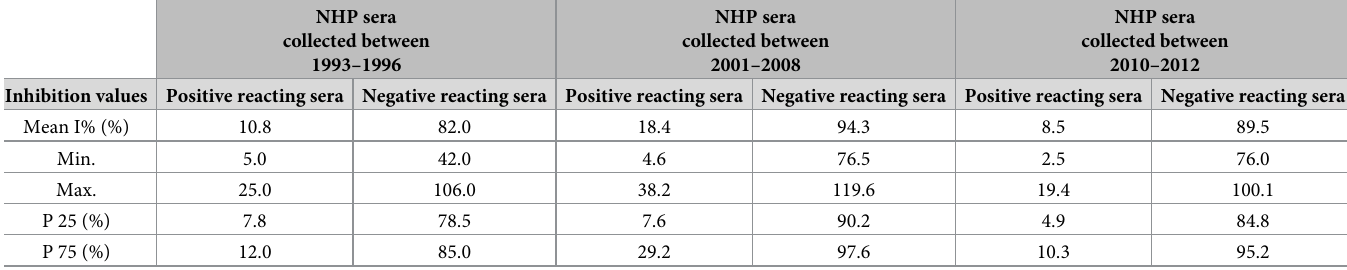
Table 3. Serological statistical values obtained with the West Nile Competition Multi-species ELISA testing wild non-human primates (NHP) of Costa Rica between 1993 and 2012. NHP sera collected